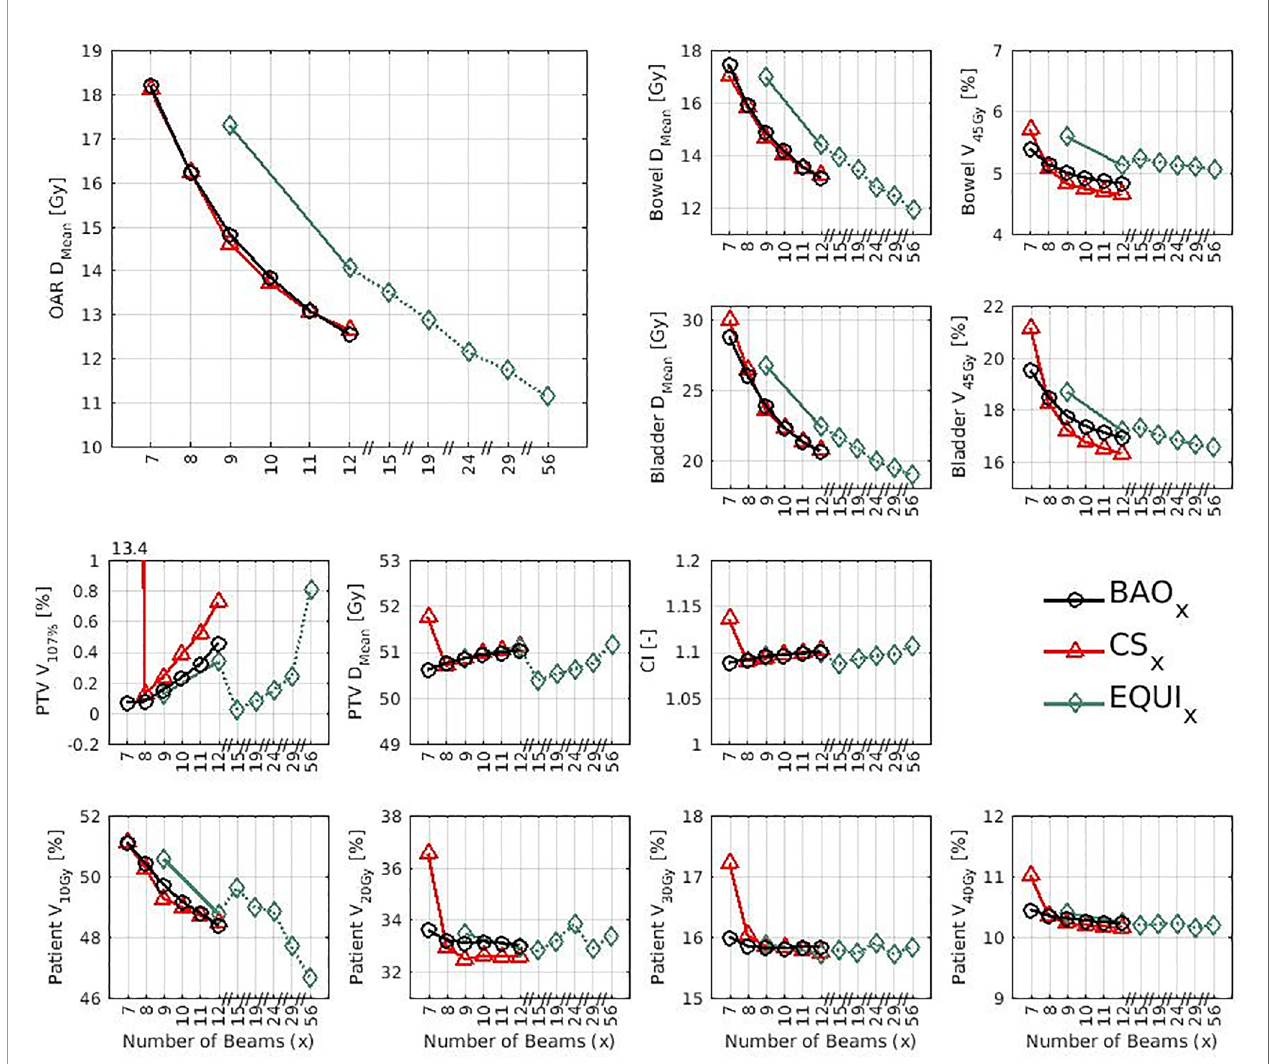
FIGURE 2 | Mean dose parameters for the 23 study patients. The top left shows the results for the composite OAR, the clinically most important healthy tissue structure. Note the non-continuity of the x-axes. P-values for all mutual comparisons of beam angle approaches can be found in Figures A3 - A14 in Electronic Supplement A. Leave-one-out data was used for CS x